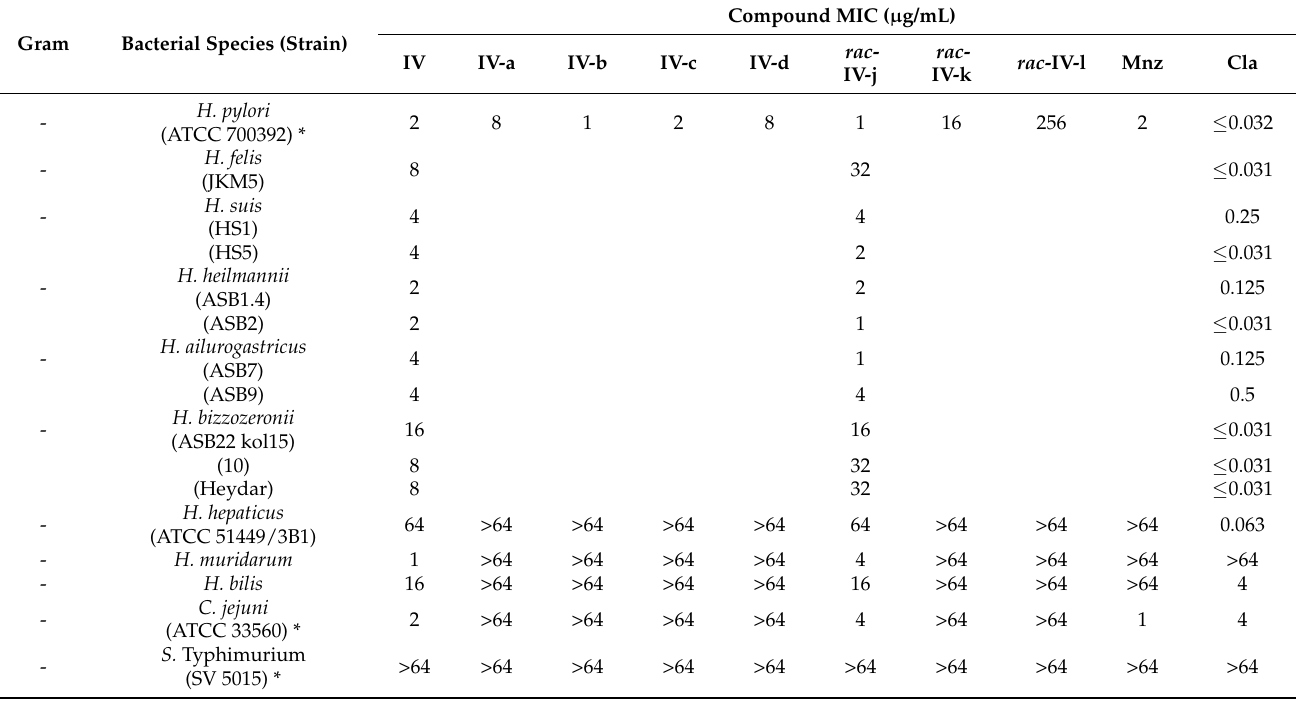
Table 1. In vitro activity of IV-related compounds against several bacteria from different